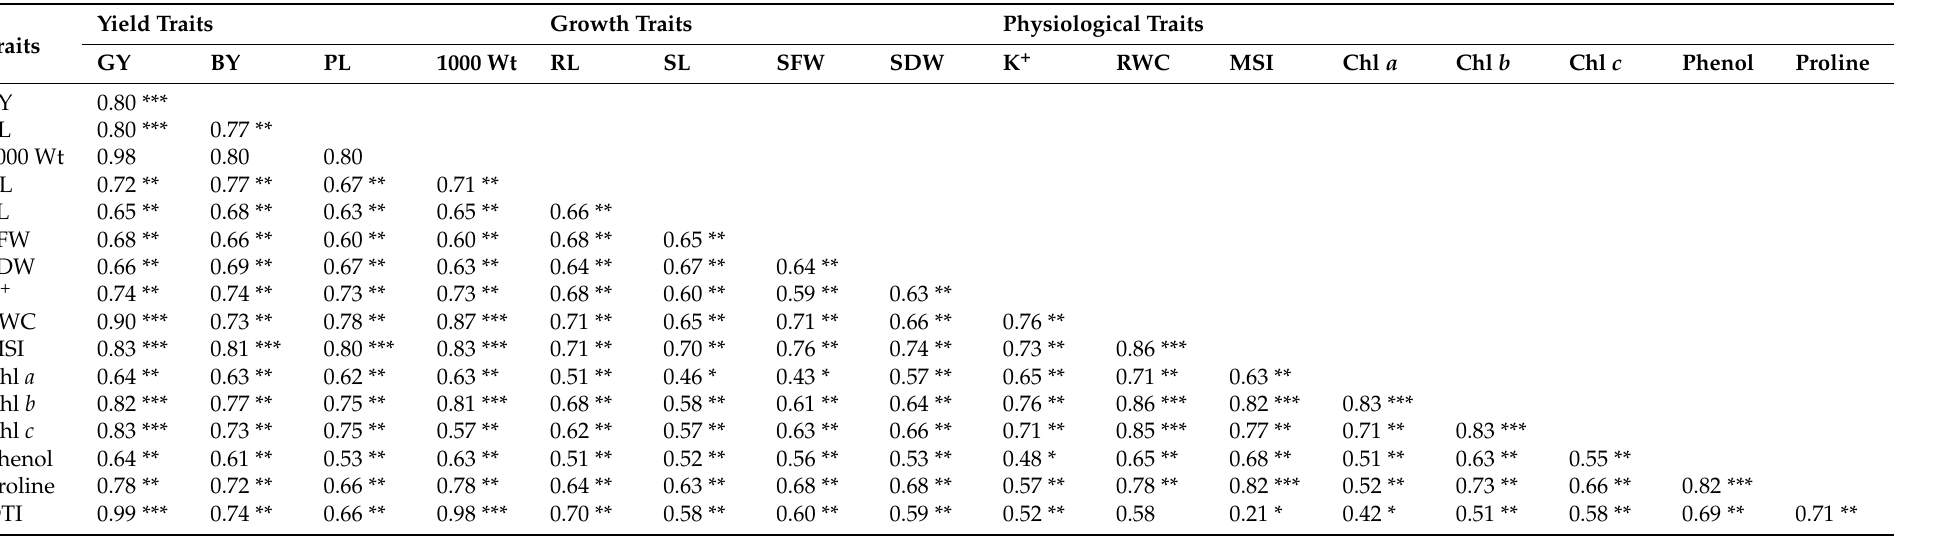
Table 6. Correlation among grain yield, seedling growth traits, and different physiological